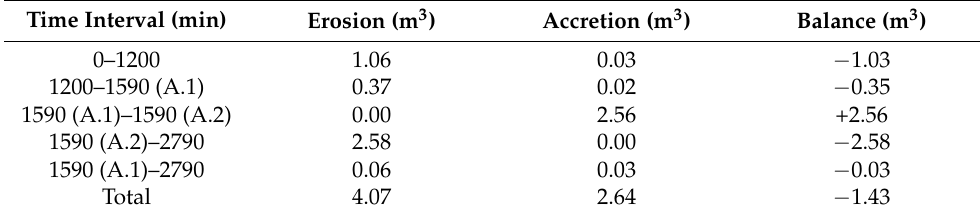
Table 3. Erosion and accretion volumes at the monitored area.